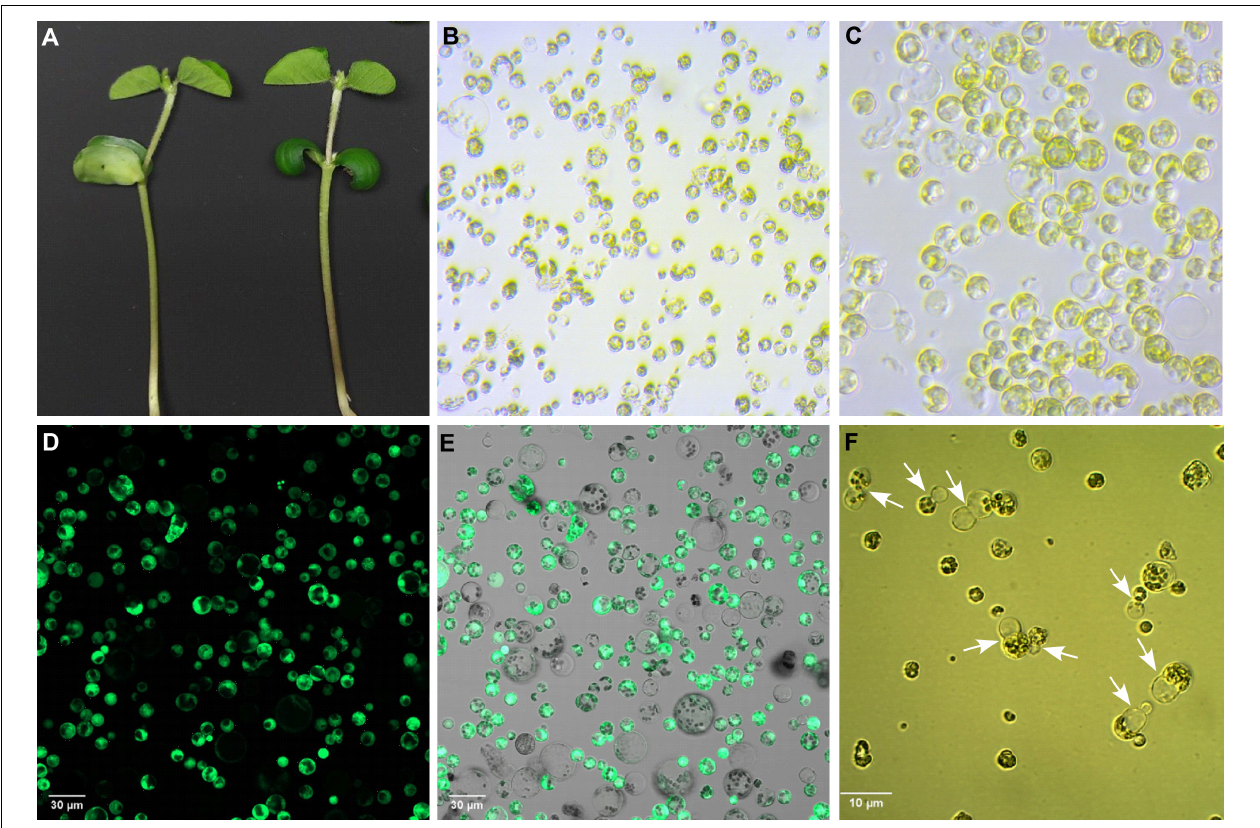
FIGURE 3 | Isolation, purification, and cultivation of protoplasts from Glycine max cv. OAC Bayfield. (A) Unifoliate leaves of 10-day-old soybean seedlings. (B) Freshly isolated protoplasts. (C) Washed and purified protoplasts. (D) FDA-stained protoplasts subjected to confocal fluorescence microscopy to visualize viable cells (GFP-positive). (E) Merged image of green channel (GFP) and ESID channel (transmitted light detection) showing all protoplasts. (F) Protoplasts undergoing cell division (indicated by white arrows) in culture medium after 3 days of